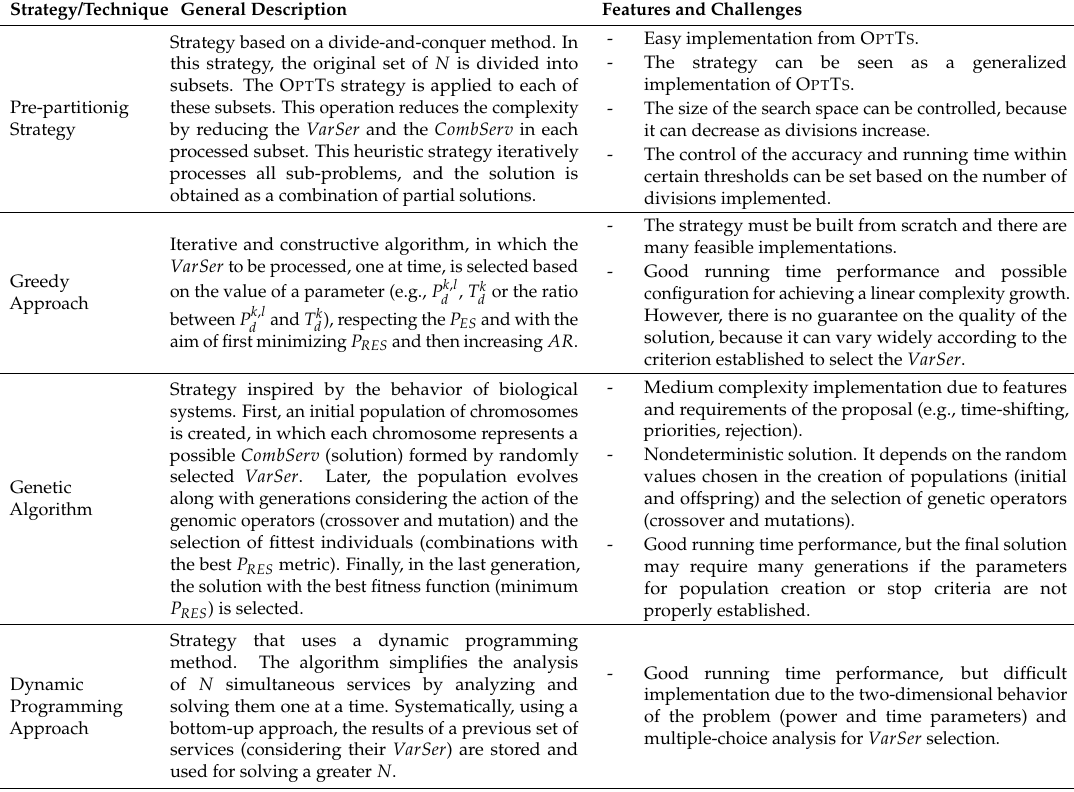
Table 4. Heuristics strategies analyzed to solve the P RES minimization problem